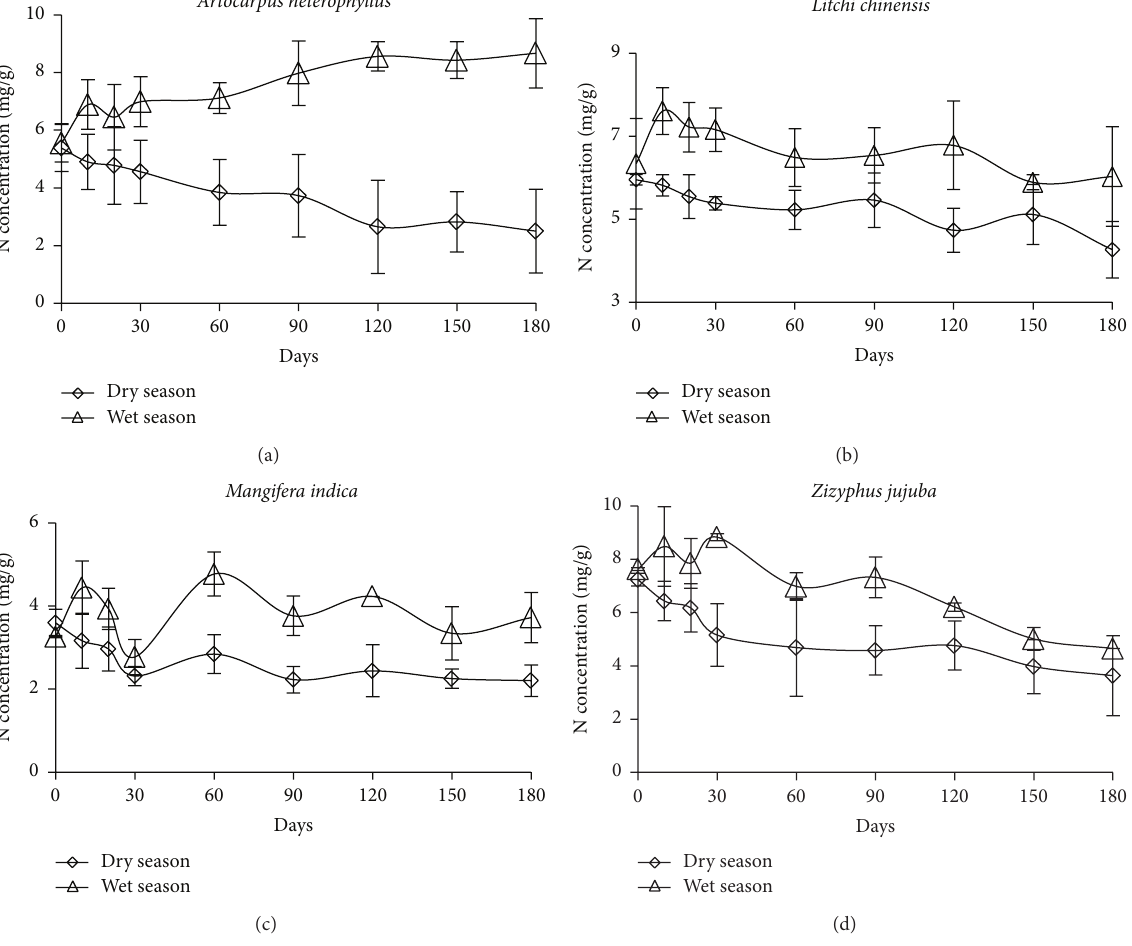
Figure 3: N concentration (mg/g) of leaf litter of four tree species used in agroforestry during the dry and wet seasons over 180-day periods due to microbial